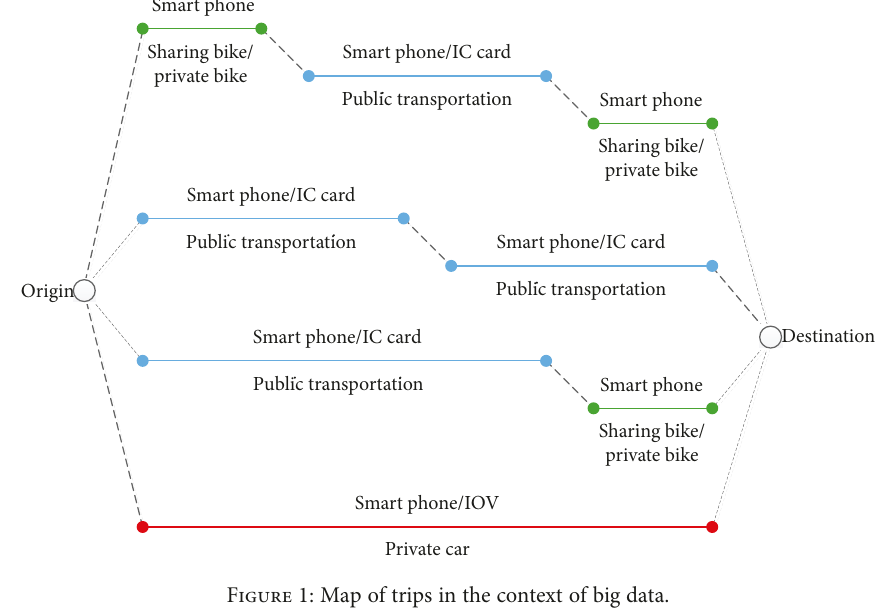
Figure 1: Map of trips in the context of big data.